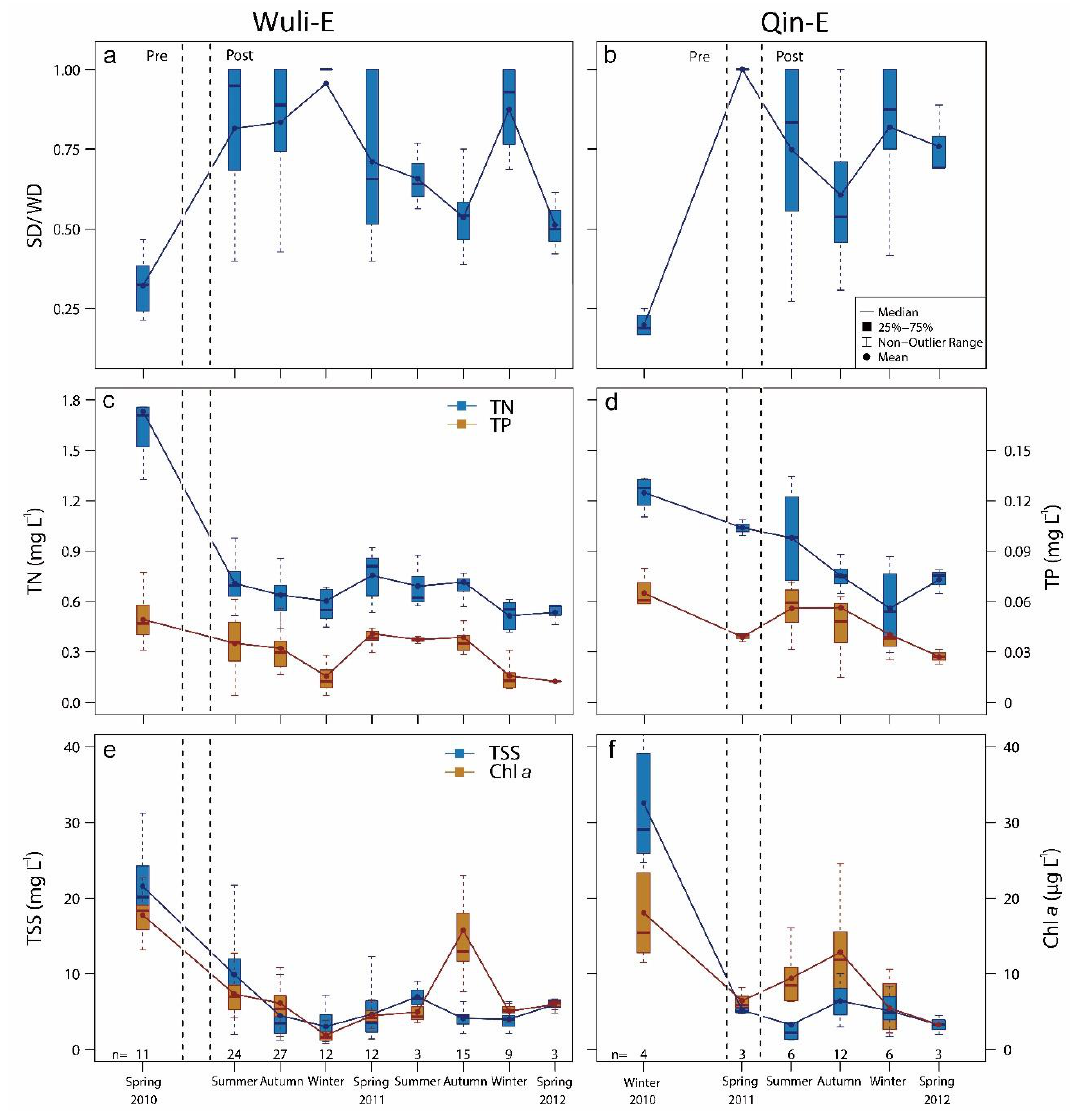
Figure 3. Seasonal variation in SD / WD (Secchi depth / water depth ratio) ( a ) and ( b ) and concentrations of total phosphorus (TP), total nitrogen (TN) ( c ) and ( d ), total suspended solids (TSS) and chlorophyll a (Chl a ) ( e ) and ( f ) in the restored areas of Lake Wuli (Wuli-E, left panel) and Lake Qinhu (Qin-E, right panel). ‘Pre’ refers to the period before restoration and ‘Post’ refers to the period of post-restoration. The date of execution of the restoration was shown between the two dashed lines. Spring was considered to be March, April and May. All monitoring data collected from three sites of every lake in each season were used in the boxplot and the numbers of samples (n) were shown above the